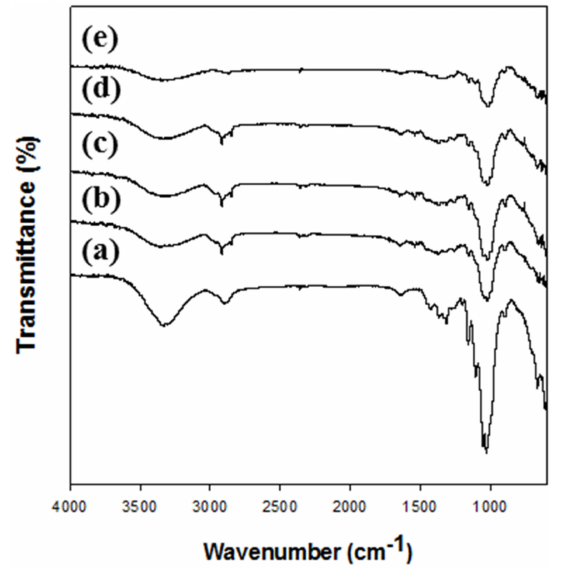
Figure 1. FT-IR spectra of Microcrystalline cellulose (MCC) and regenerated celluloses. ( a ) MCC, ( b ) Cell-IL, ( c ) Cell-NaTU, ( d ) Cell-TBAH, and ( e )